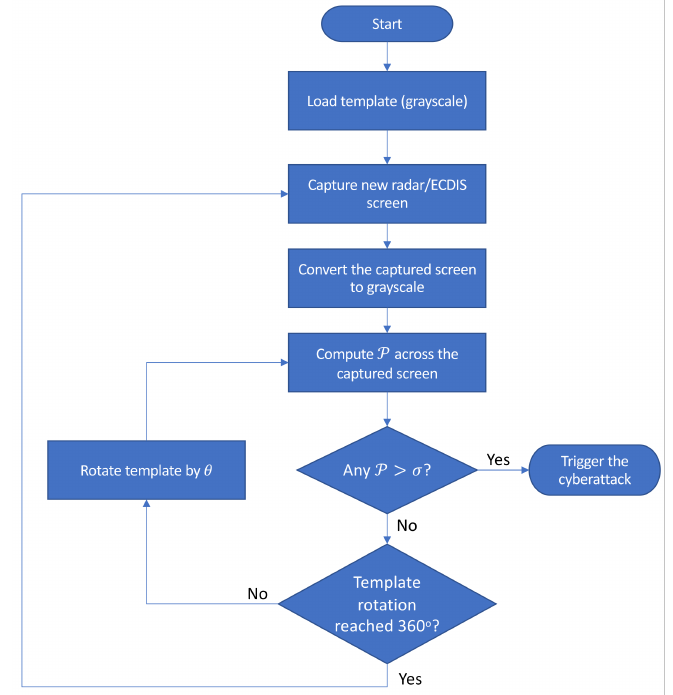
Figure 8. Flowchart of the triggering